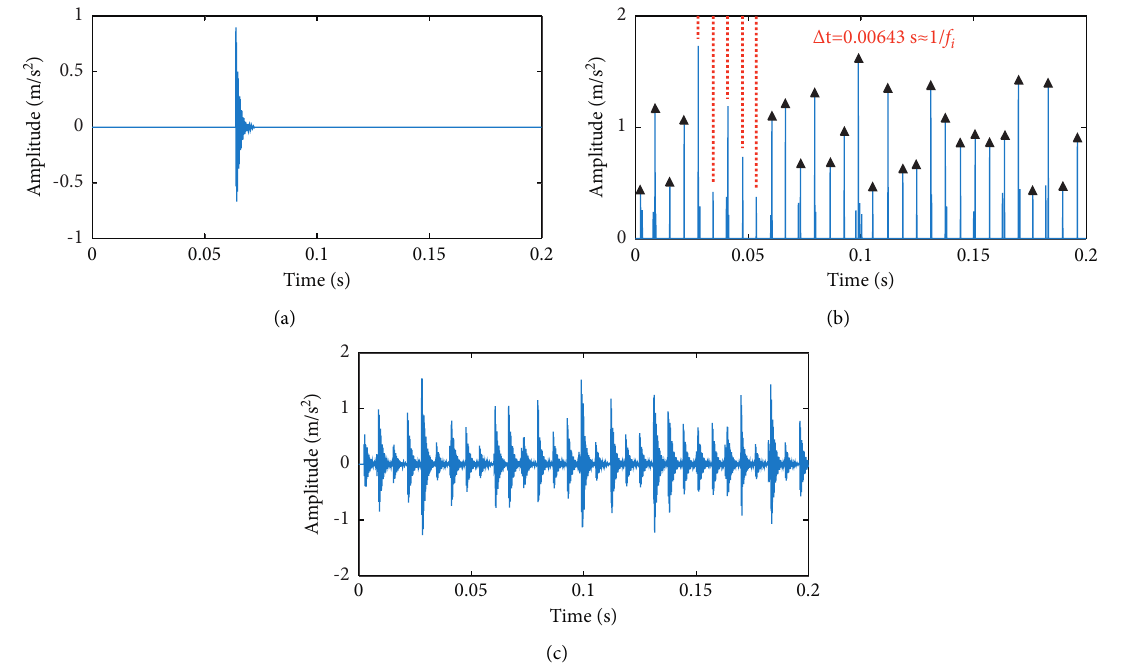
Figure 9: The results of sparse representation of the vibration signal of the weak fault of the bearing inner ring. (a) The optimal Laplace wavelet atom. (b) Sparse representation coefficients. (c) The reconstructed